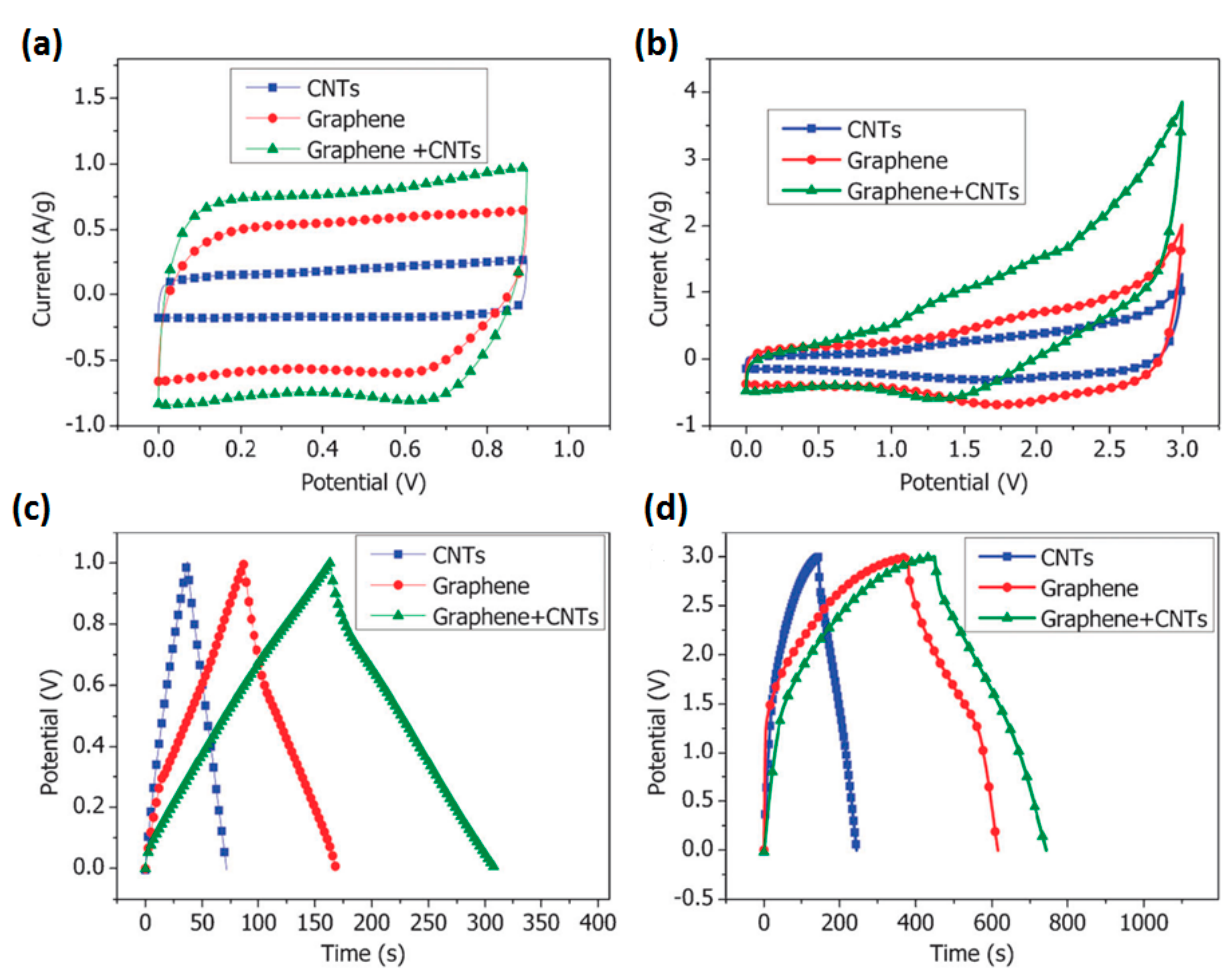
Figure 9. Electrochemical properties of various electrodes made of CNTs, graphene, and graphene/CNT composite. ( a ) Cyclic voltammetry curves in the aqueous KCl electrolyte at a scan rate of 10 mV/s. ( b ) Cyclic voltammetry curves in 1 M TEABF 4 /PC electrolyte at the same scan rate of 10 mV/s. ( c ) Galvanostatic charge/discharge curves in the aqueous electrolyte at a charging current of 500 mA/g. ( d ) Galvanostatic charge/discharge curves in the organic electrolyte at the same charging current of 500 mA/g (Reproduced with permission of [29]. Copyright Royal Society of Chemistry, 2011).